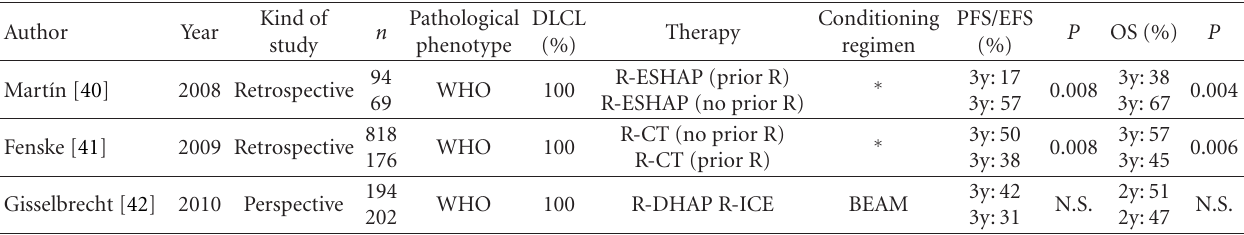
Table 5: Salvage therapy in relapsing/refractory DLBCLs previously exposed to